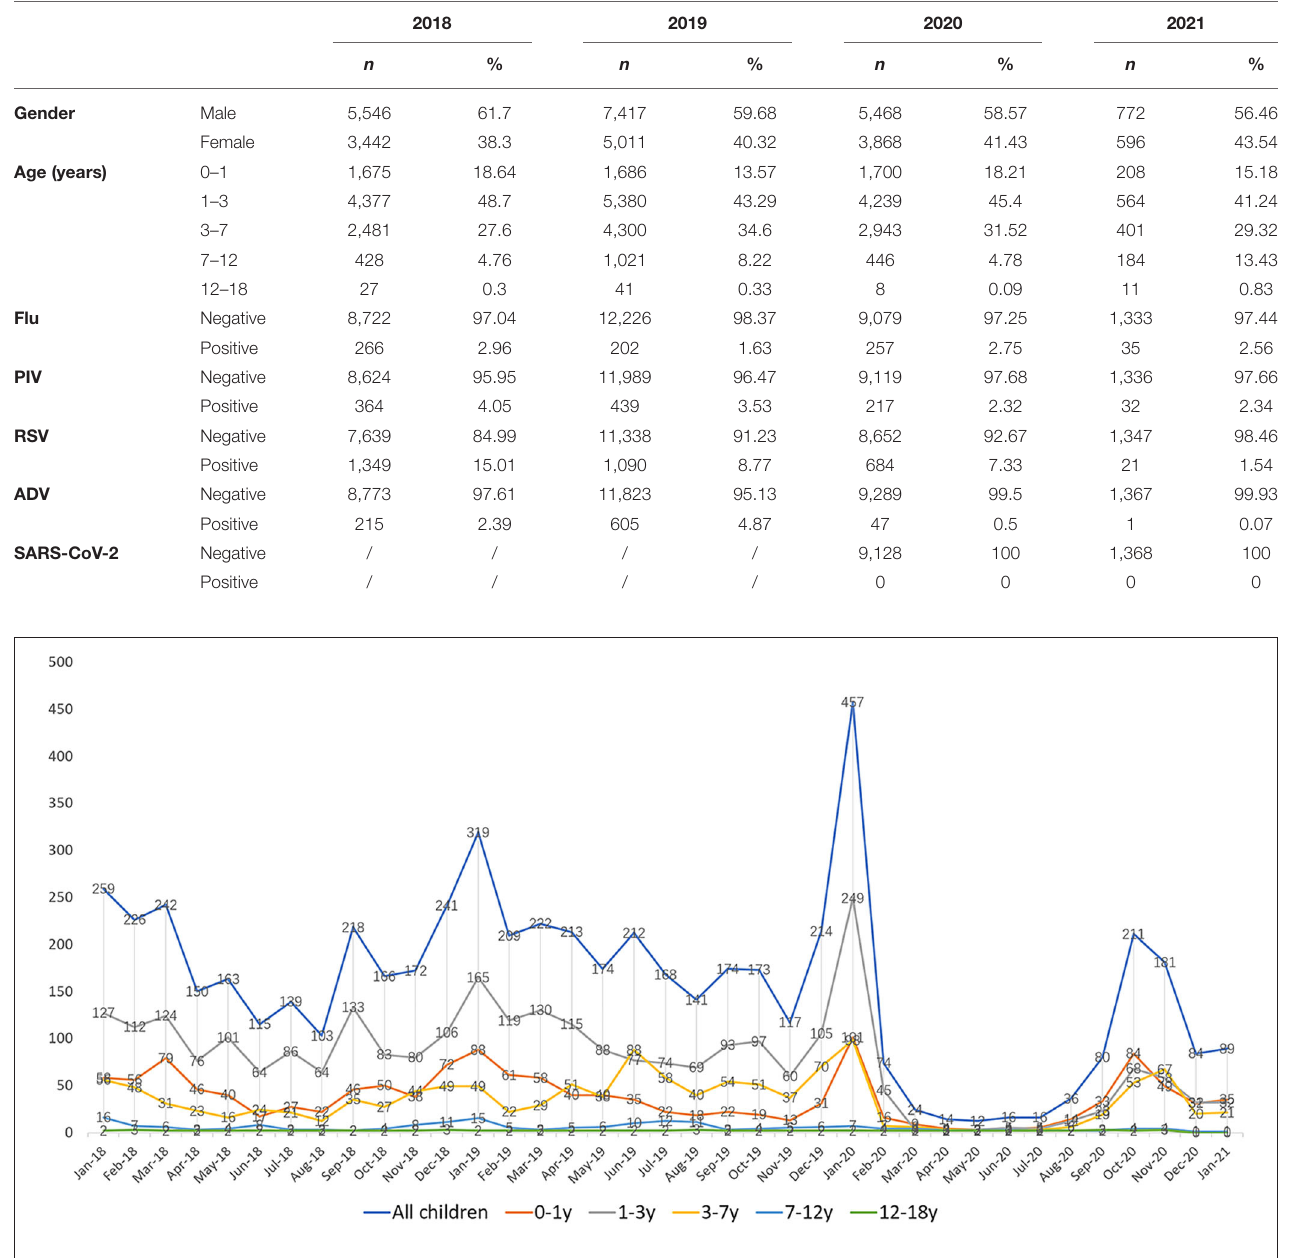
FIGURE 1 | Infection of four major respiratory viruses in children of different ages from January 1, 2018 to January 31, 2021.